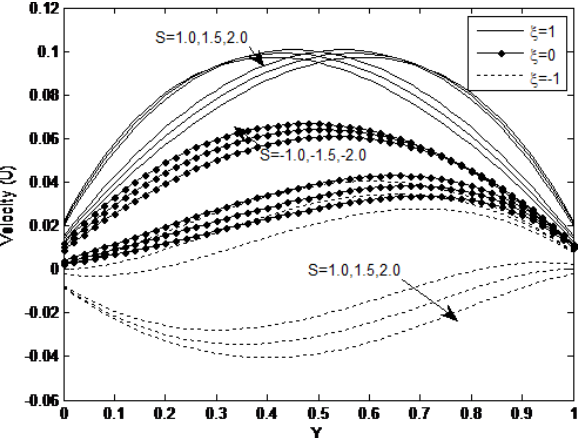
Fig. 3: Effect of suction/injection on velocity